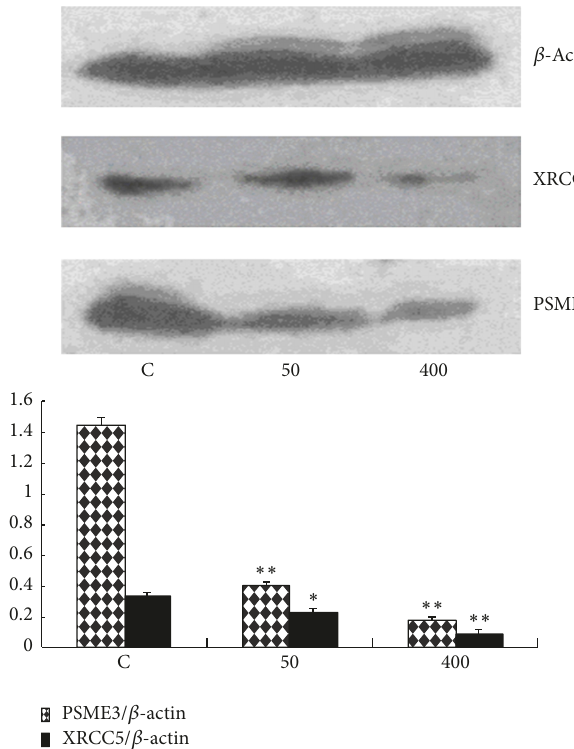
Figure 6: Effect of elaidic acid on expression of XRCC 5 and PSME 3 proteins. C: normal HUVEC as control; 50: HUVEC treated with 50 𝜇 mol/L elaidic acid; 400: HUVEC treated with 400 𝜇 mol/L elaidic acid. ∗ indicated a significant difference (𝑝 < 0.05) ; ∗∗ indicated a very significant difference (𝑝 < 0.01) , when compared to the control group.